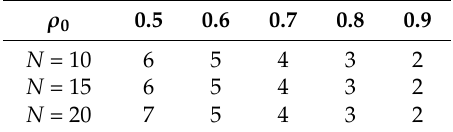
Table 7. Number of representative nodes with distortion D = 0.15.